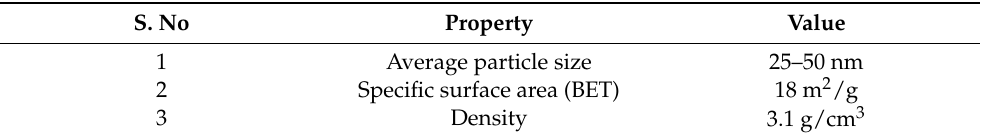
Table 4. Silicon carbide